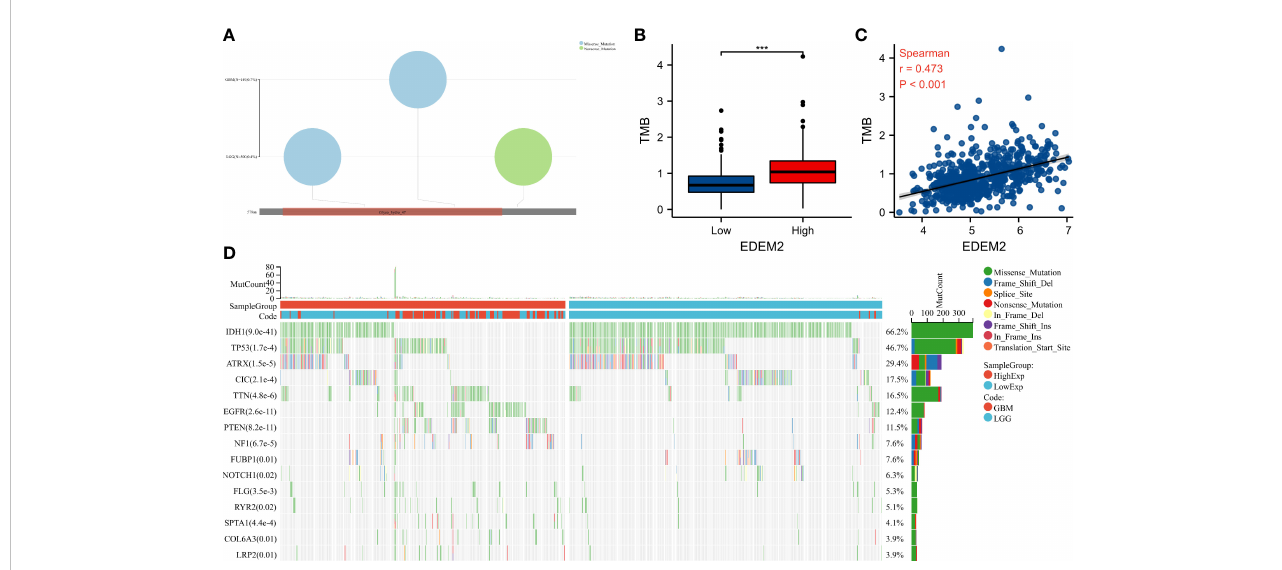
FIGURE 7 The mutation landscape and tumor mutation burden (TMB) of different EDEM2 expressions in the TCGA cohort. (A) Mutation pro fi le in EDEM2. (B) Comparison of TMB between the two groups. (C) The correlation of TMB scores with EDEM2. (D) Differences in gene mutations between the two groups. ***p<0.001.